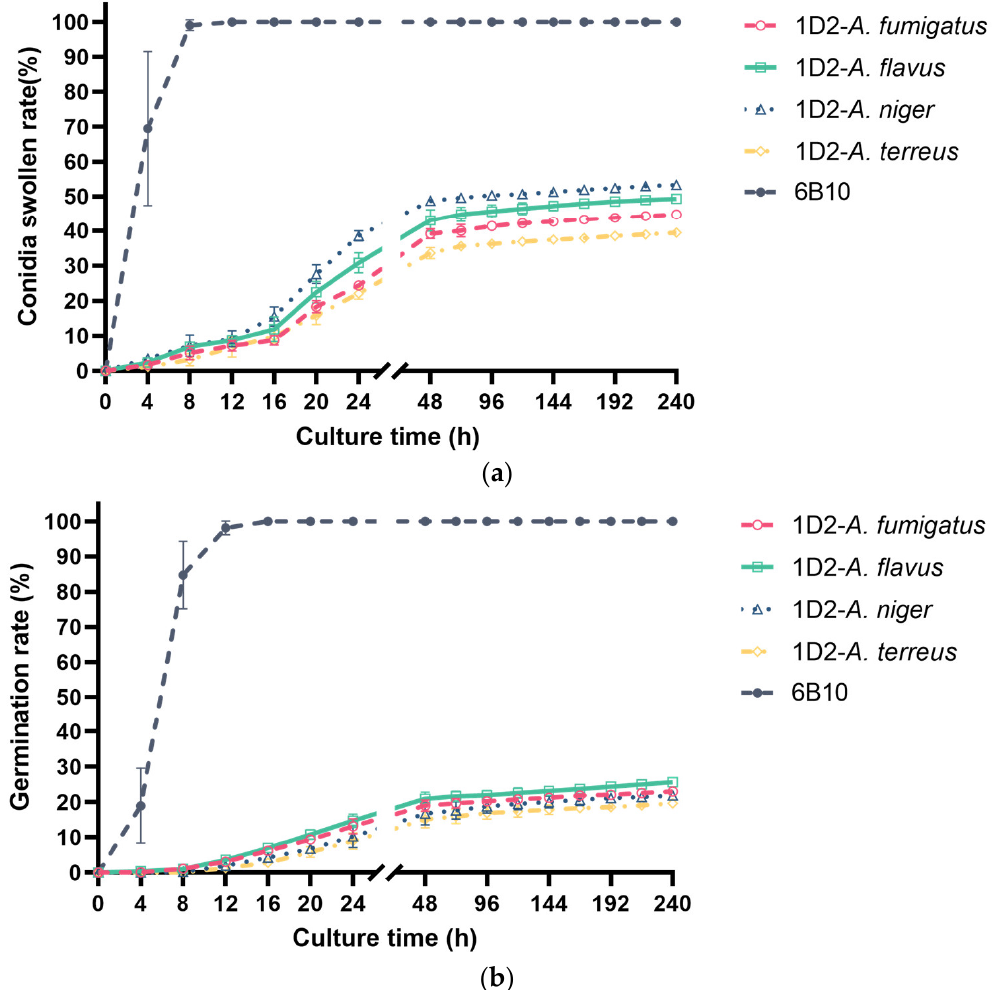
Figure 4. Swelling and germination rate of different Aspergillus conidia against mAb 1D2. The mAb 1D2 markedly delayed both the swelling ( a ) and germination process ( b ) ( p < 0.001) for A. fumigatus , A. flavus , A. niger and A. terreus . While there were slight conidia swelling prior to 16 h, swelling and germination continued and reached a stationary phase after 48 h. Conversely, the control mAb 6B10 did not show apparent interference on conidial swelling ( a ) or germination ( b ). The resting conidia started to swell within the first two hours of incubation and were almost completely swollen when cultured for 8 h ( a ). The swollen conidia activated germination when incubated for 4 h, and most of them germinated after 10 h ( b ).